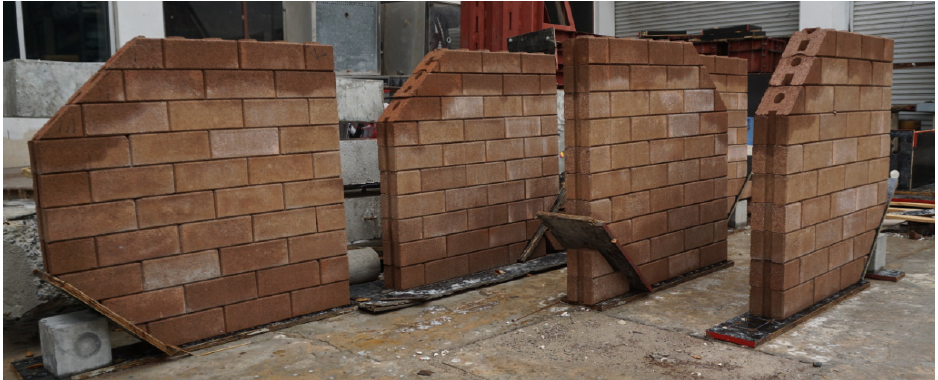
Figure 6. Typical construction of CCIHBM walls.